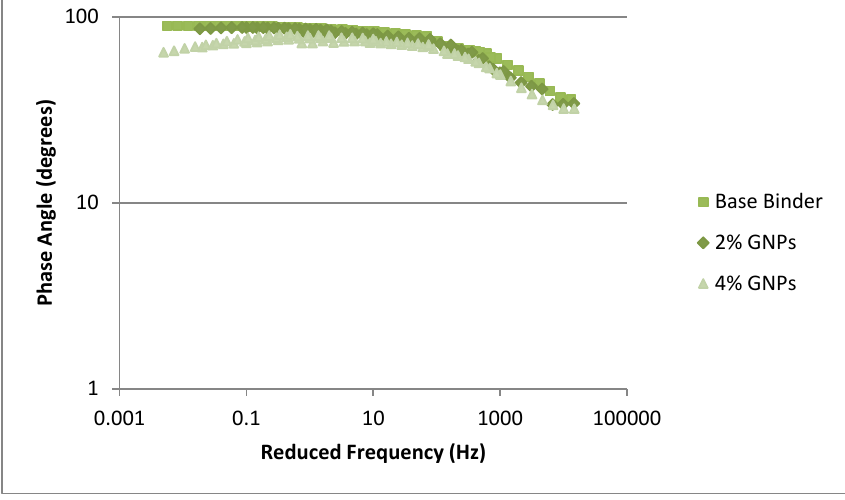
Figure 7. The Master Curve for the Phase Angle at 50 °C. GNPs = Graphene Nano-Platelets.